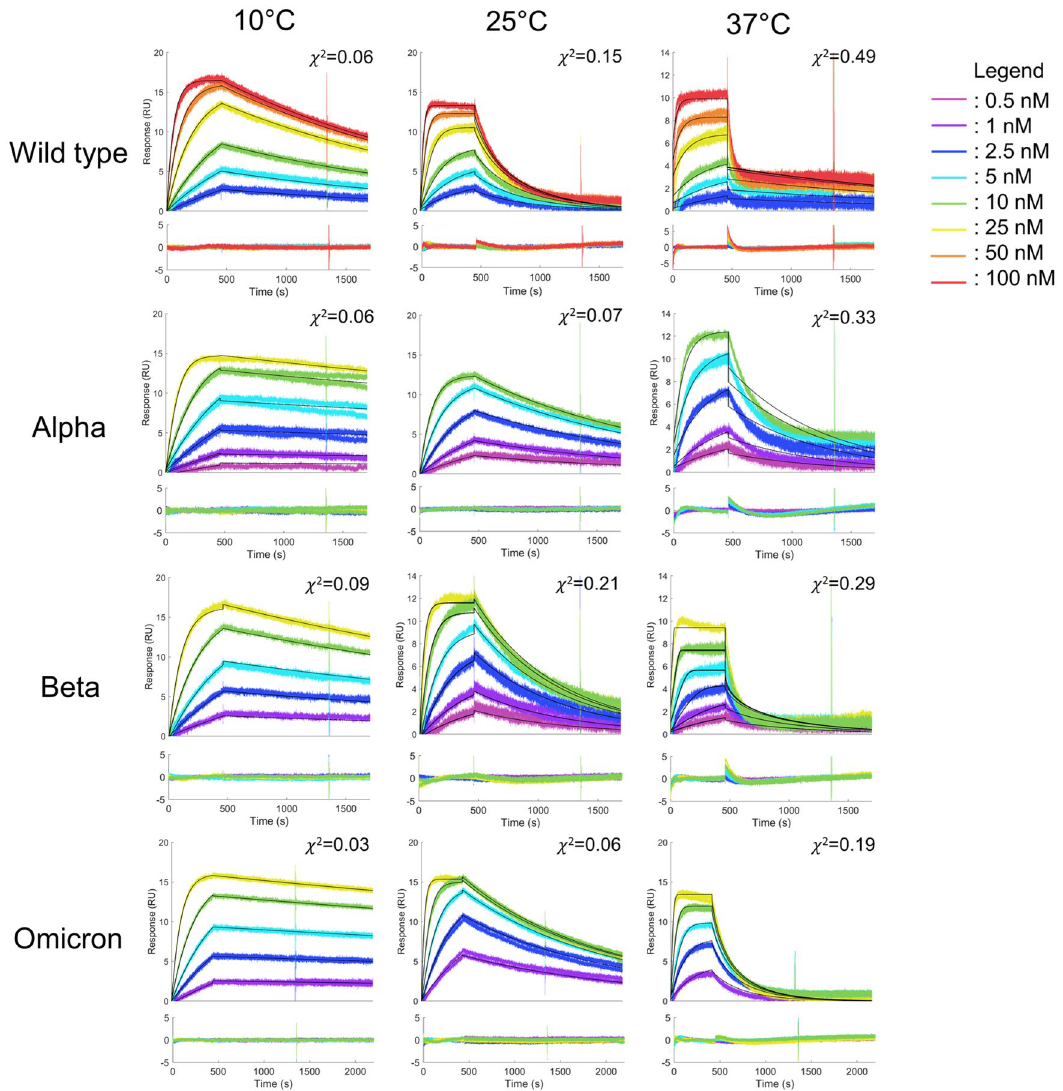
Figure 2. SPR sensorgrams recorded for the RBD variants that do not contain the L452R mutation interacting with tethered ACE2 at different temperatures. The sensorgrams corresponding to variant injections at 10, 25 and 37 °C were globally fitted with a 1:1 Langmuir binding model (solid black lines). Residual plots are included underneath each sensorgram